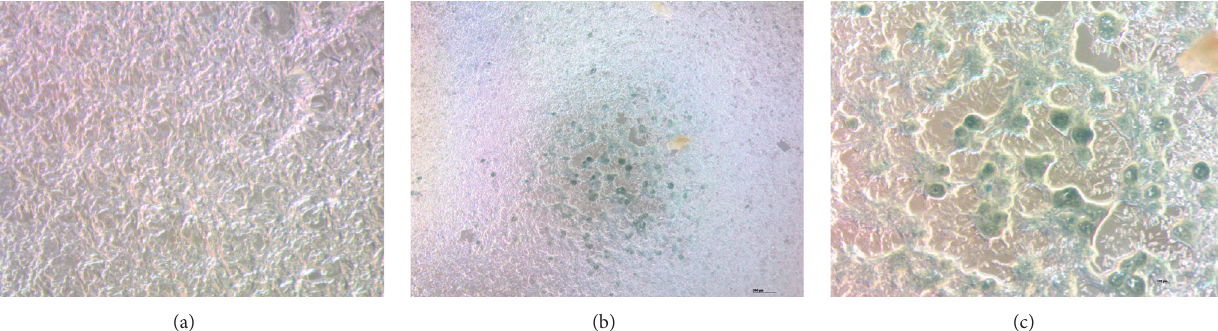
Figure 2: Detection of senescent cells. Qualitative SA- 𝛽 -Gal assay of the most representative donors’ canine adipose derived stem cells in passage 4. A local region of senescence cell is shown (b, c). Negative control cells (a).